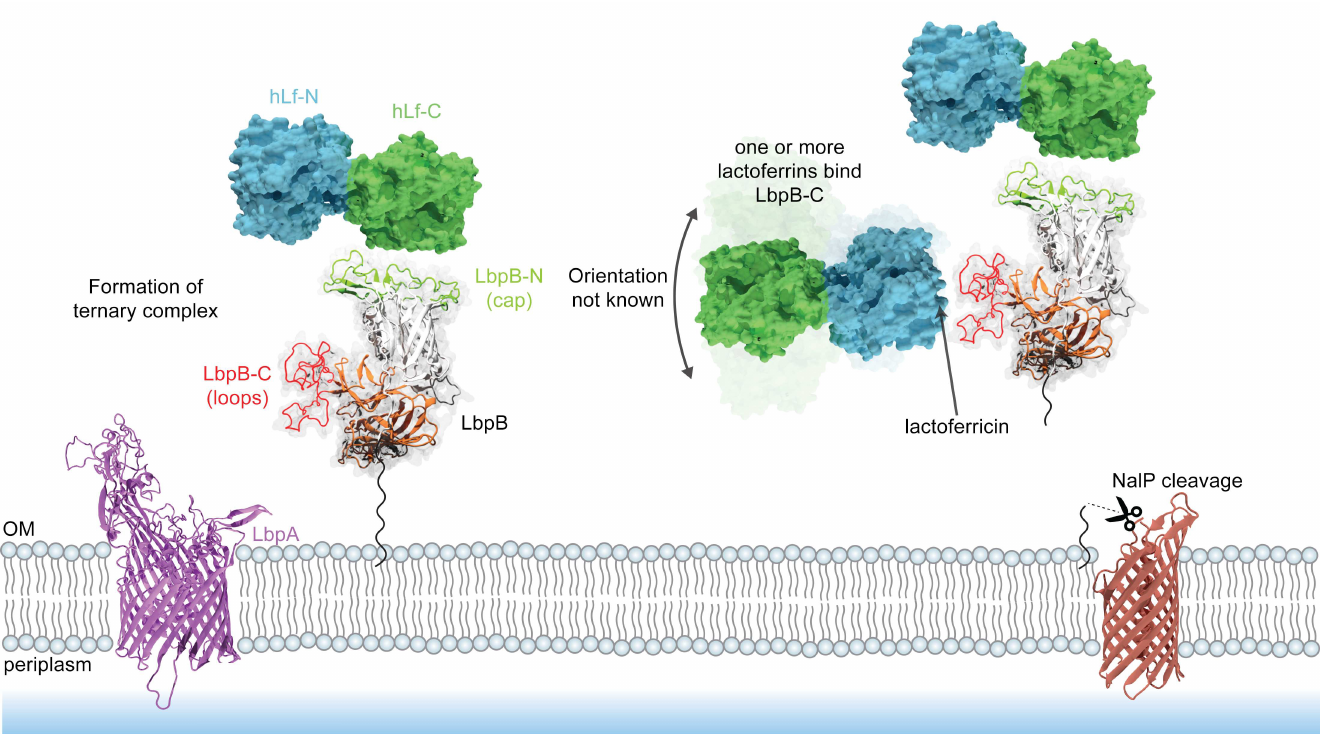
Fig 5. Proposed functions of LbpB. (LEFT) LbpB may be involvedin the iron-acquisition pathway. At low concentrations of holo-hLf, LbpB may use its LbpB-Nbindingmode to preferentially bind iron-loaded lactoferrin and shuttle it to LbpA, forming a ternary complexand hijacking the iron. (RIGHT) Cleavage of LbpB from the membranemay be dependenton the presenceof high levelsof hLf in the extracellular milieu or simplya constitutive propertyof N . meningitidis cells in the NalP phase-variable ON-state. The releaseof LbpB from the membrane is donein an effort to sequesterlactoferricin, antibodies, andpossiblyform large lattices of hLf as to prevent proteolytical processing into its derivativecationicantimicrobial peptides.